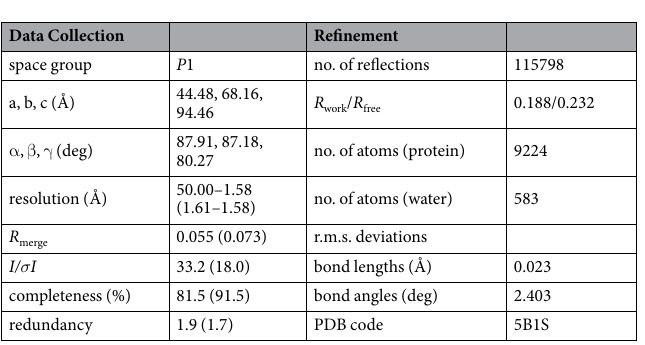
Table 2. Crystallographic analysis statistics of the TcSpdSyn-compound 1